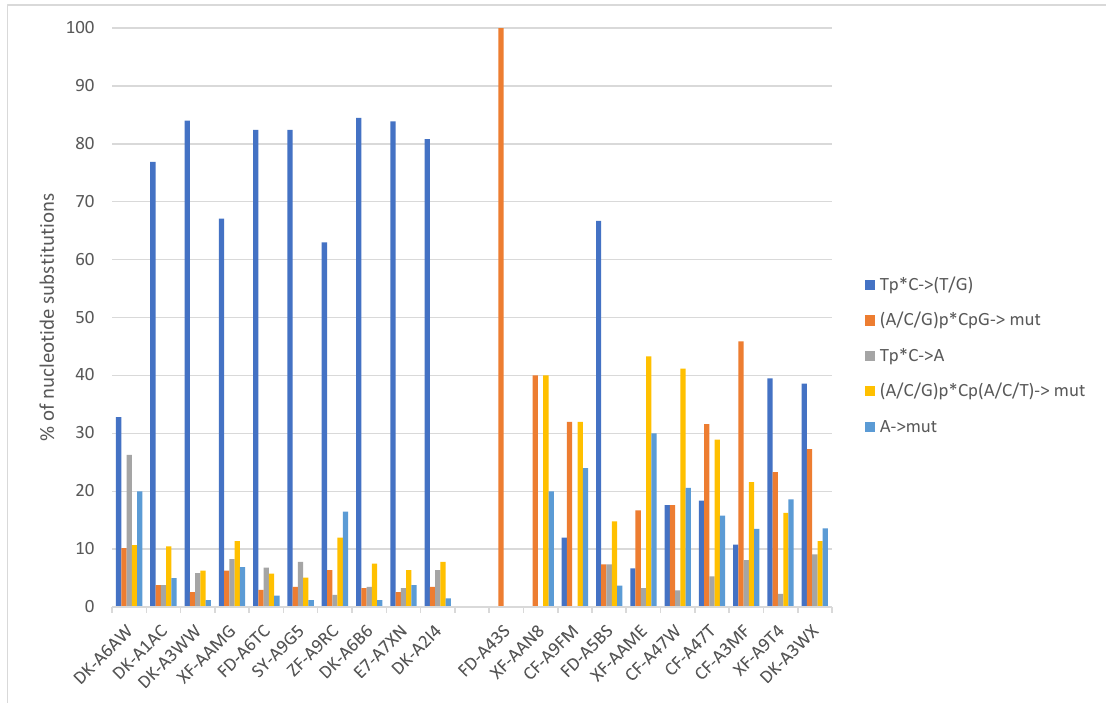
Figure 4. Base substitutions in representative samples with high TMB (left part of the figure) and samples with low TMB (right part of the figure). High TMB cases are dominated by signatures 2 and 13 (Tp*C > T/G) while low TMB cases are dominated by signature 5 (C > T/G/A). The identification code of evaluated cases is shown along the horizontal axis.